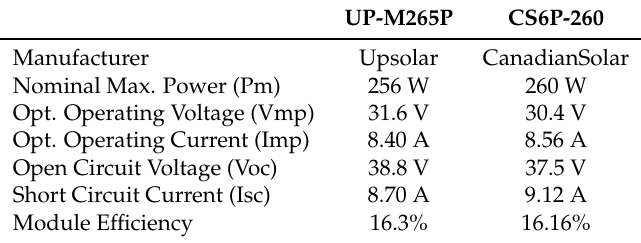
Table 3. Technical specification of photovoltaic